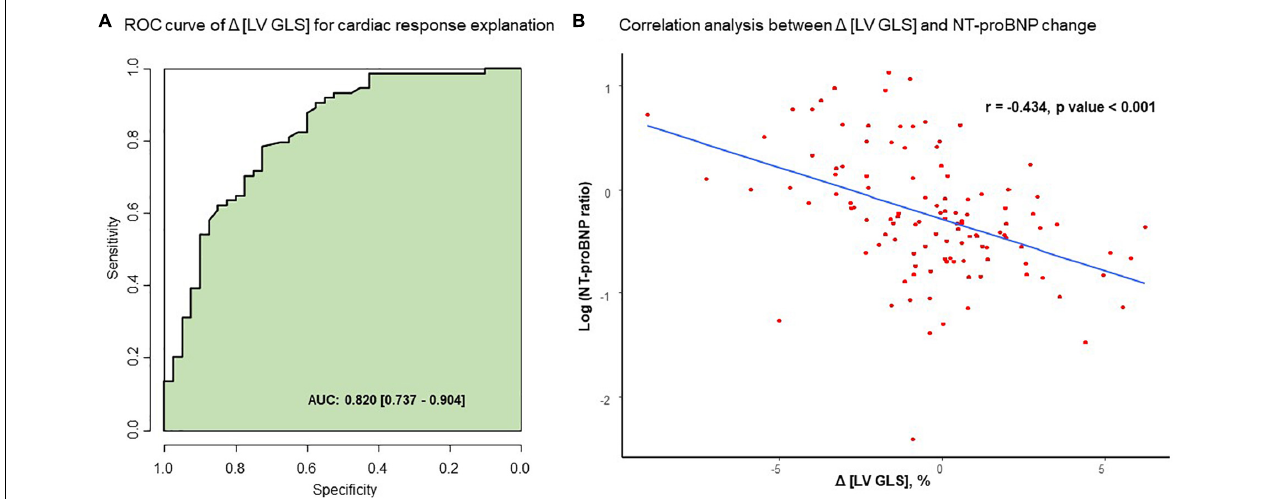
FIGURE 5 | Correlation between (cid:49) [LV GLS] and NT-proBNP change after chemotherapy. (A) ROC curve of (cid:49) [LV GLS] for cardiac response explanation. (B) Correlation analysis between (cid:49) [LV GLS] and NT-proBNP change. AUC, area under curve; (cid:49) [LV GLS], post-chemotherapy [LV GLS]—pre-chemotherapy [LV GLS]; NT-proBNP ratio, post chemotherapy NT-proBNP/pre chemotherapy NT-proNBP, ROC, receiver operating